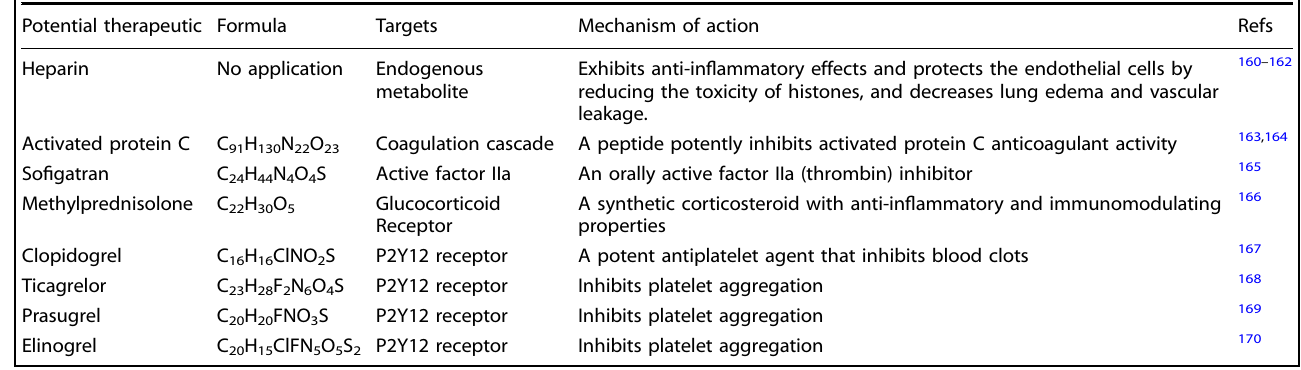
Table 3. Potential therapeutic tools for anticoagulant and antithrombotic treatment in COVID-19 Potential therapeutic